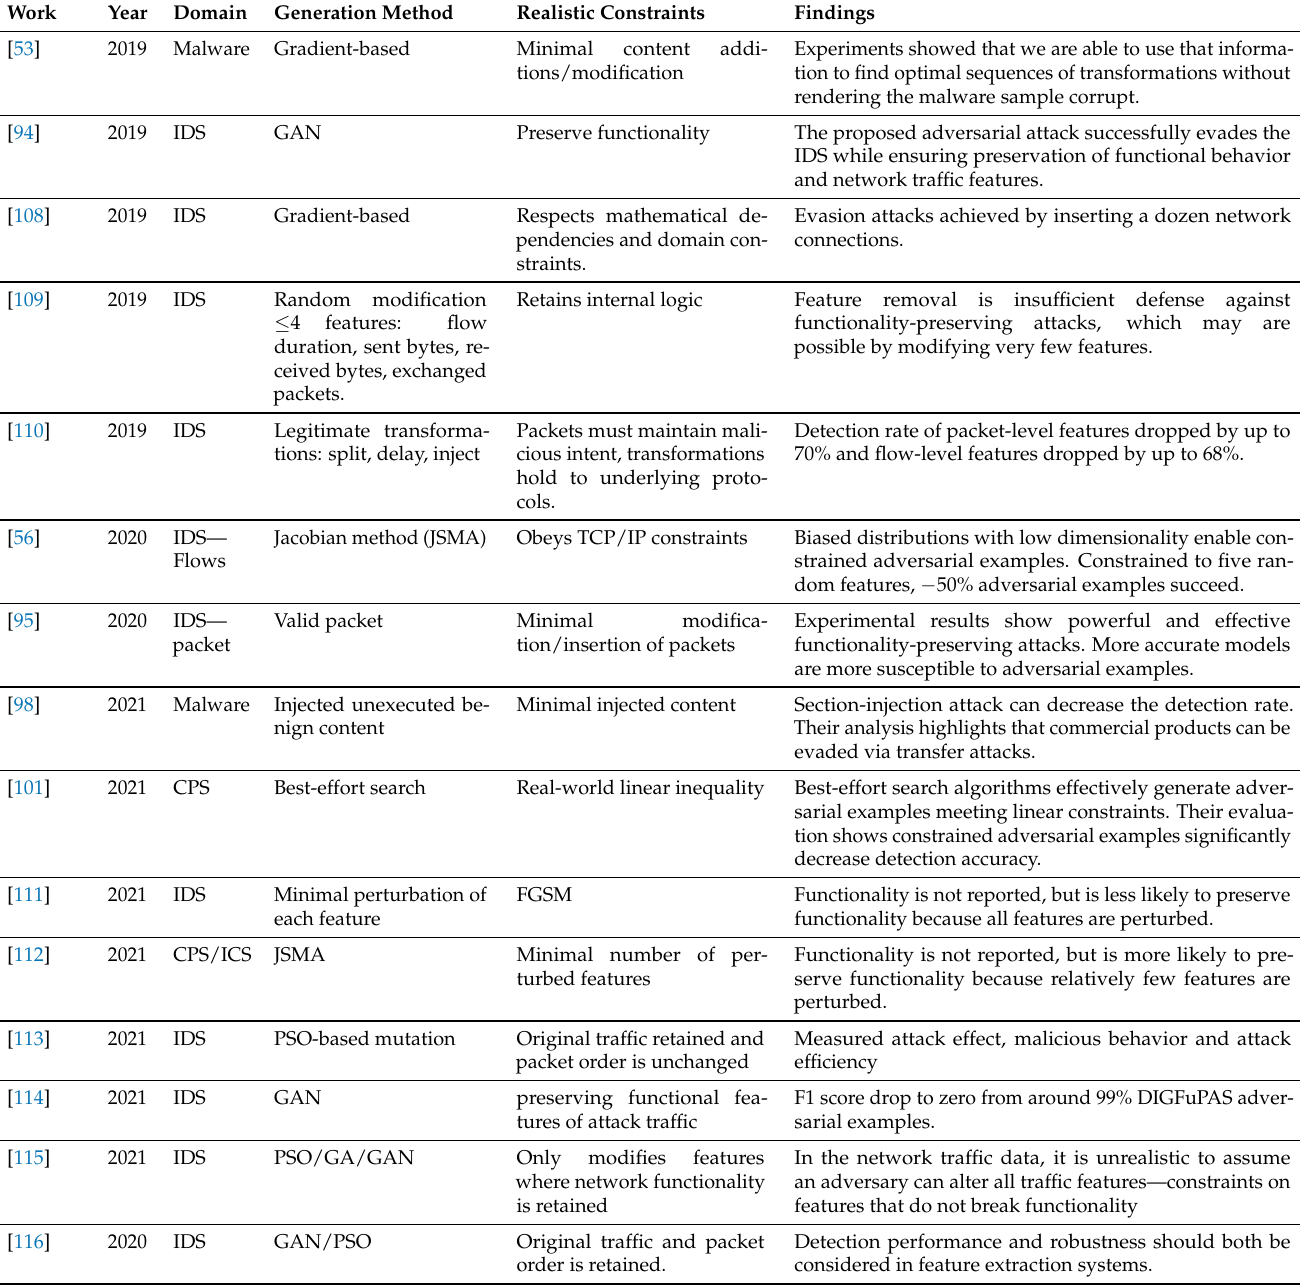
Table 7. Functionality-preservation in cybersecurity and intrusion